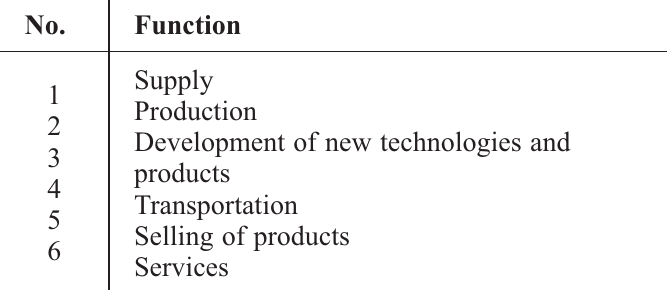
Table 1. General production functions of enterprises